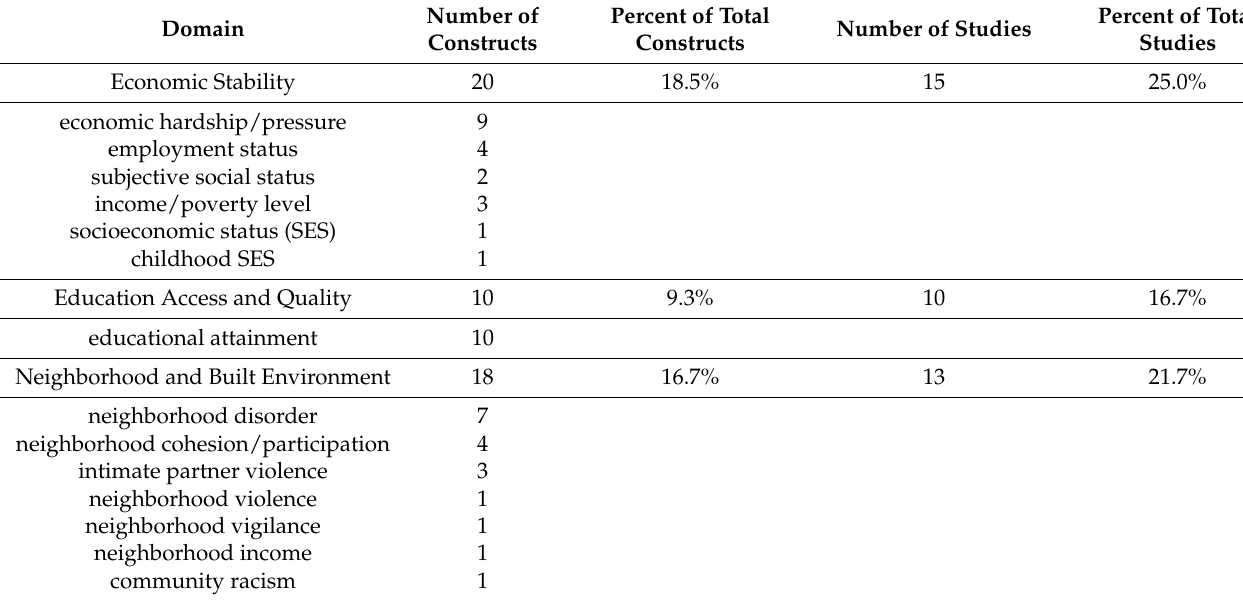
Table 1. Social Determinants of Health